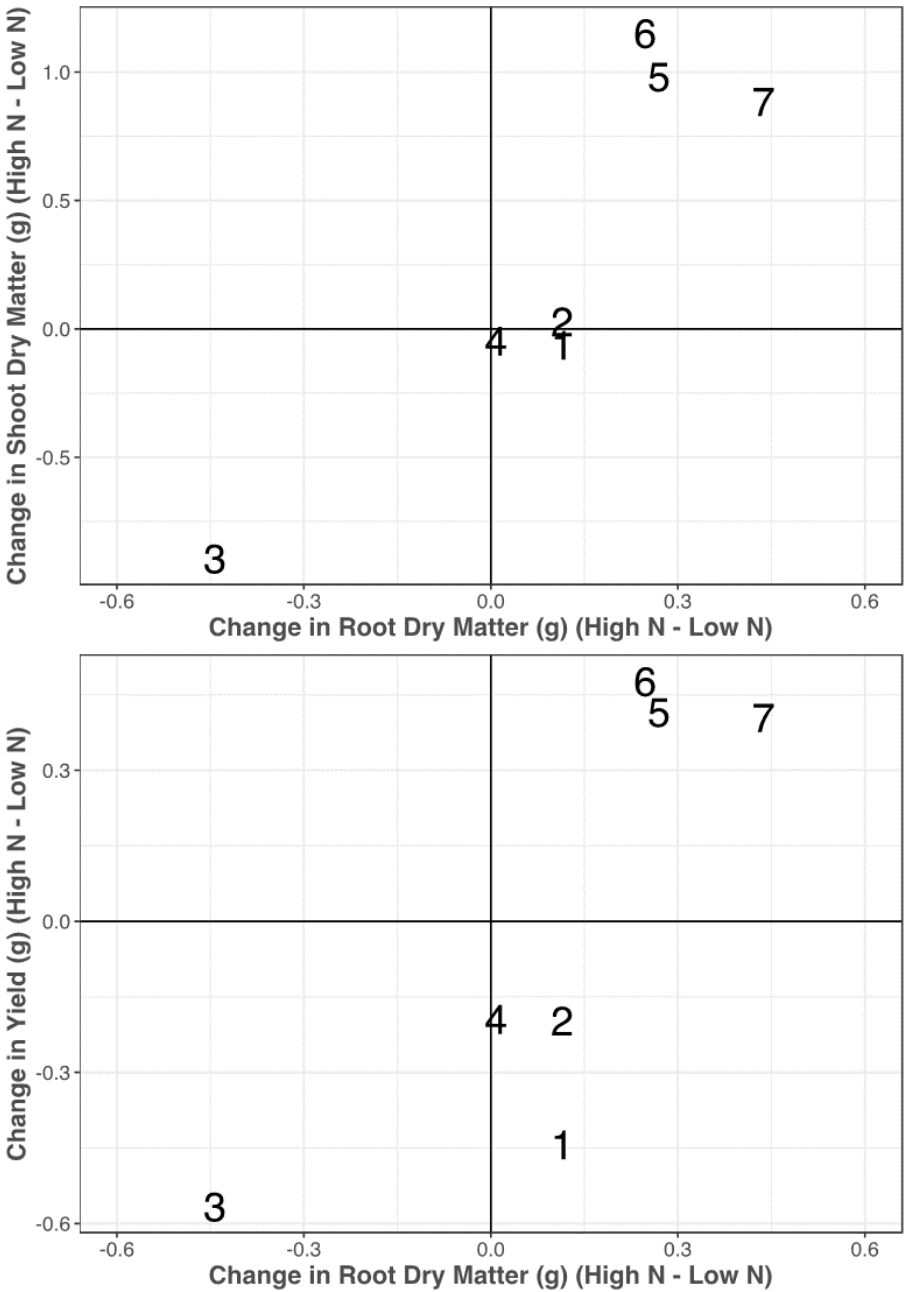
Figure 5. Variation of biomass allocation responses with regard to N treatments (high N–low N). On the x axis is the change in root dry matter with change in shoot dry matter ( top ) and change in single-plant yield ( bottom ) on the y axis. Lines are distinguished as follows: Opata (1), PI 189823 (2), PI 245427 (3), PI 519677 (4), PI 542457 (5), PI 626655 (6), and PI 94379 (7).